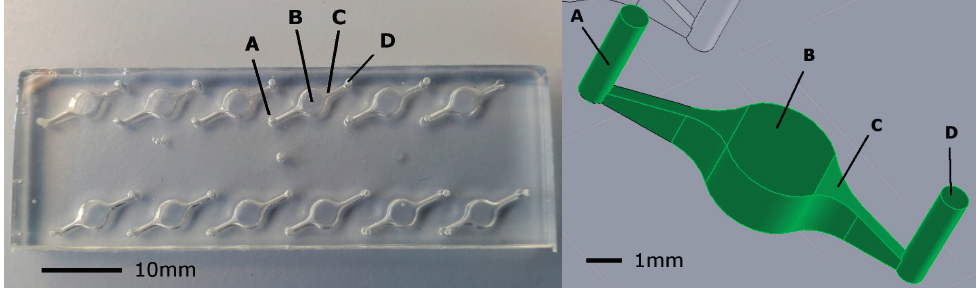
Figure 1. The prototype microfluidic chip. ( Left ) a photo (plan view) of the prototype chip showing (A) 1 mm diameter inlet port into which reaction mix was pipetted; (B) 25 µL reaction chamber: 4 mm diameter × 2 mm depth; (C) chamfered channel to prevent bubble trapping and (D) 1 mm outlet port; ( Right ) an isometric view of microfluidic reaction chamber (coloured green) to illustrate the chamfered channel geometry.